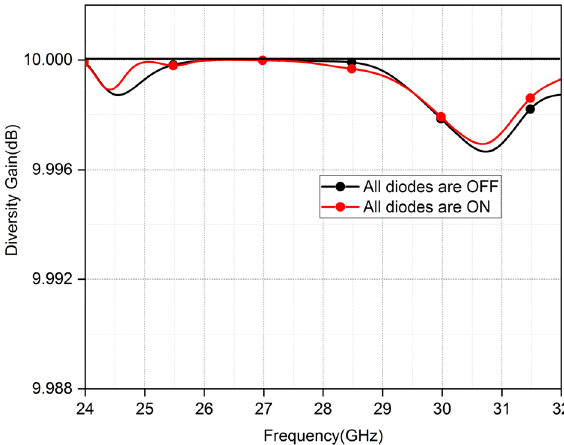
Figure 15. Diversity gain.